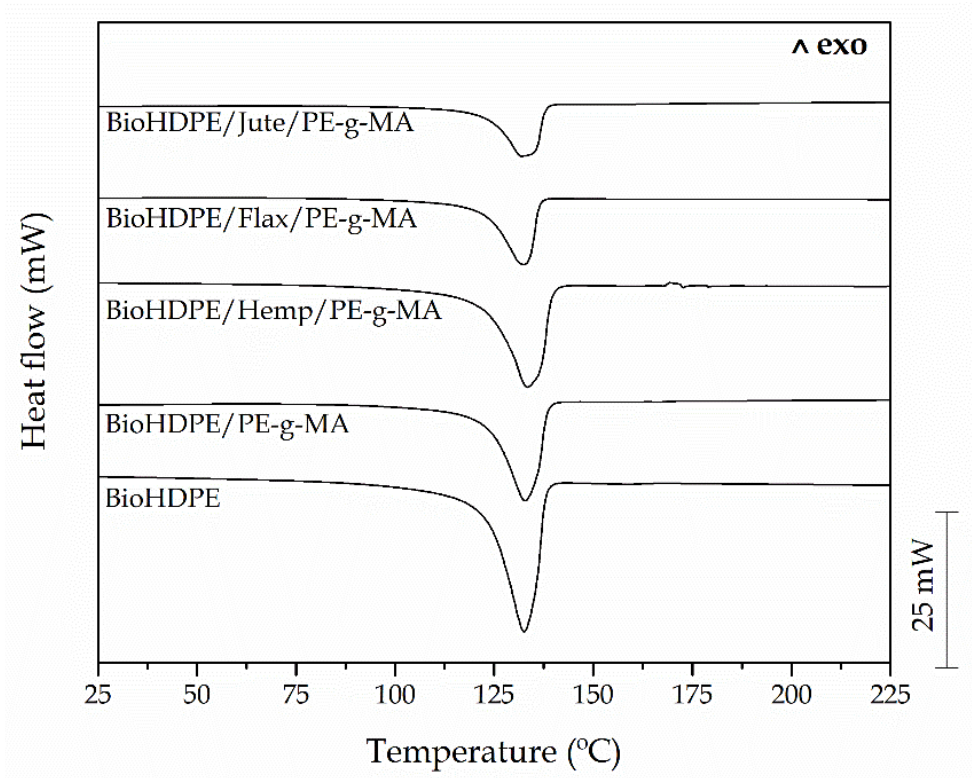
Figure 5. Differential scanning calorimetry (DSC) thermograms of BioHDPE composites with differ- ent natural fibers. Table 3. Main thermal parameters of the injection-molded parts of Bio-HDPE with different natu- ral fibers in terms of: melting temperature (T m ), normalized melting enthalpy ( ∆ H m ), and degree of crystallinity ( χ c ).